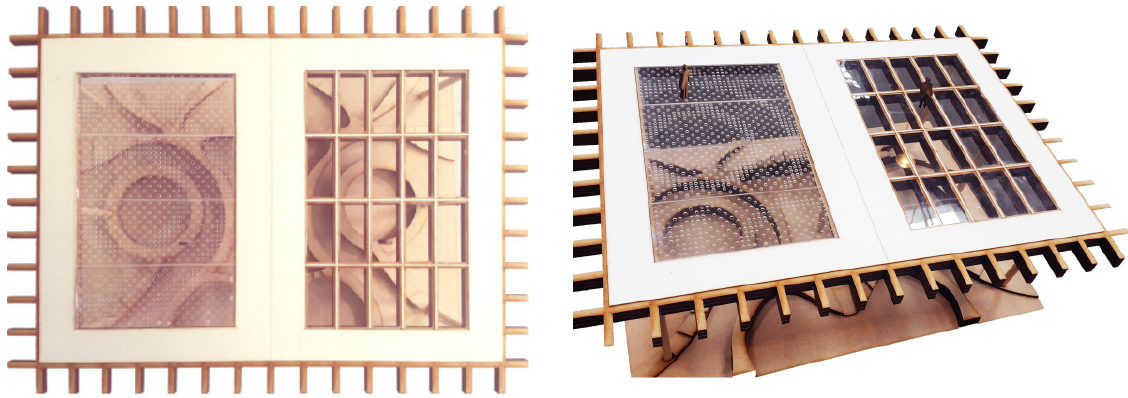
Fig. 17: model comparing the existing situation with the